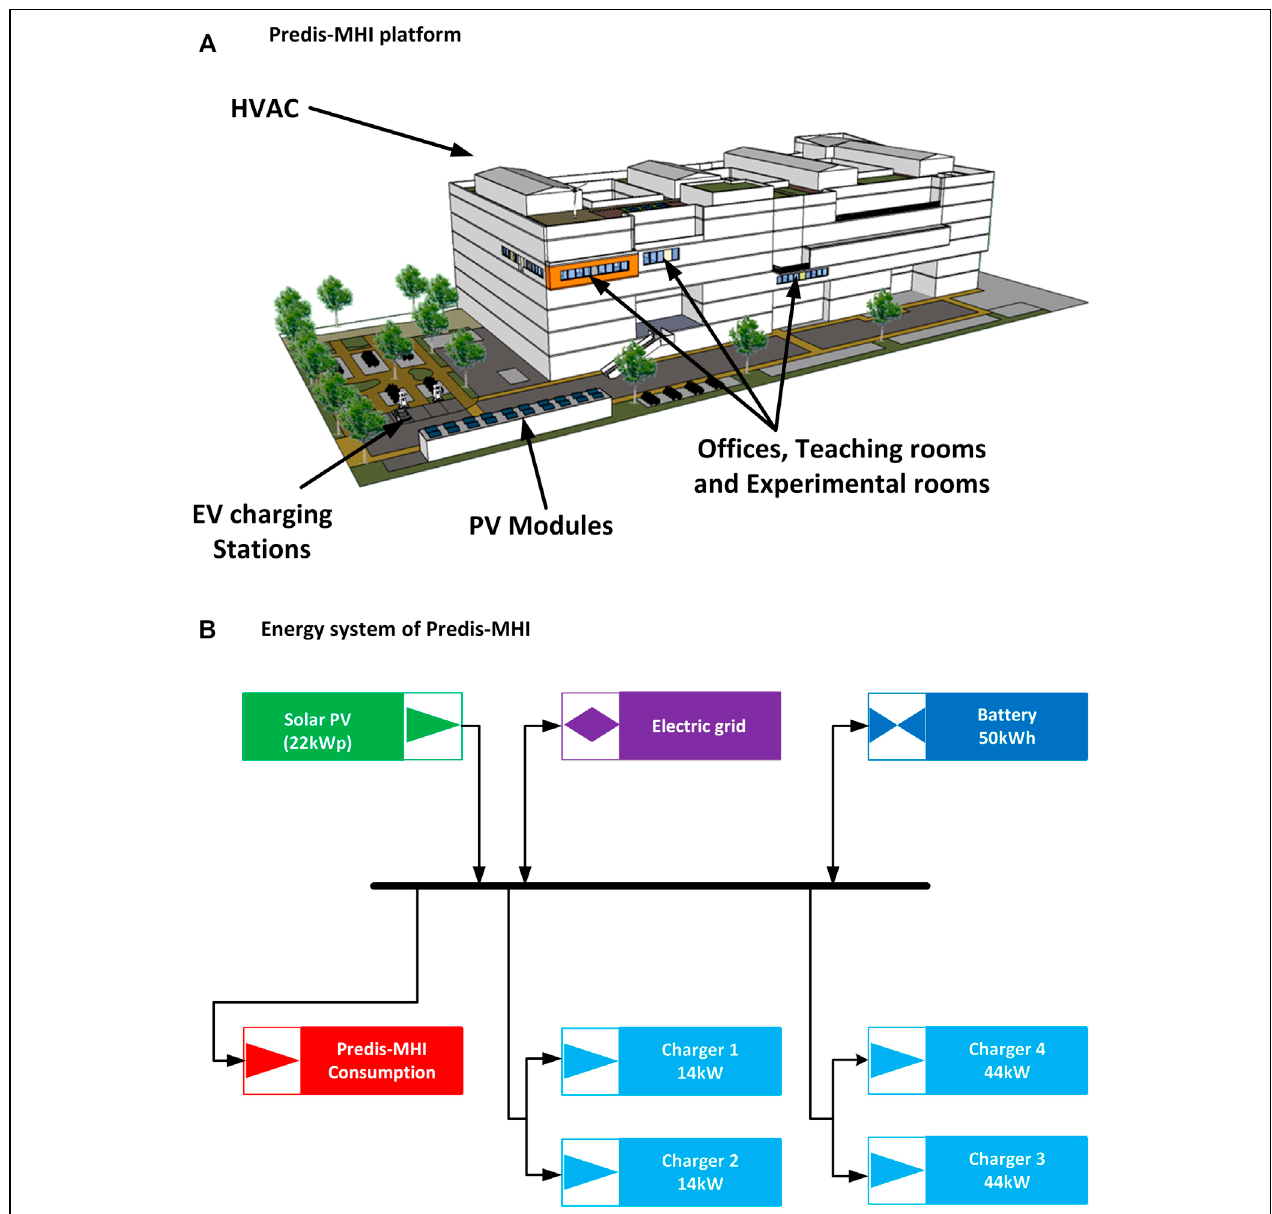
FIGURE 3 | The Predis-MHI platform (A) : Pictorial depiction of GreEn-ER building showing the Predis-MHi platform (Delinchant et al., 2016) (B) : Electricity system of the Predis-MHI (represented using OmegAlpes graphical representation (Hodencq et al., 2021a)) system.